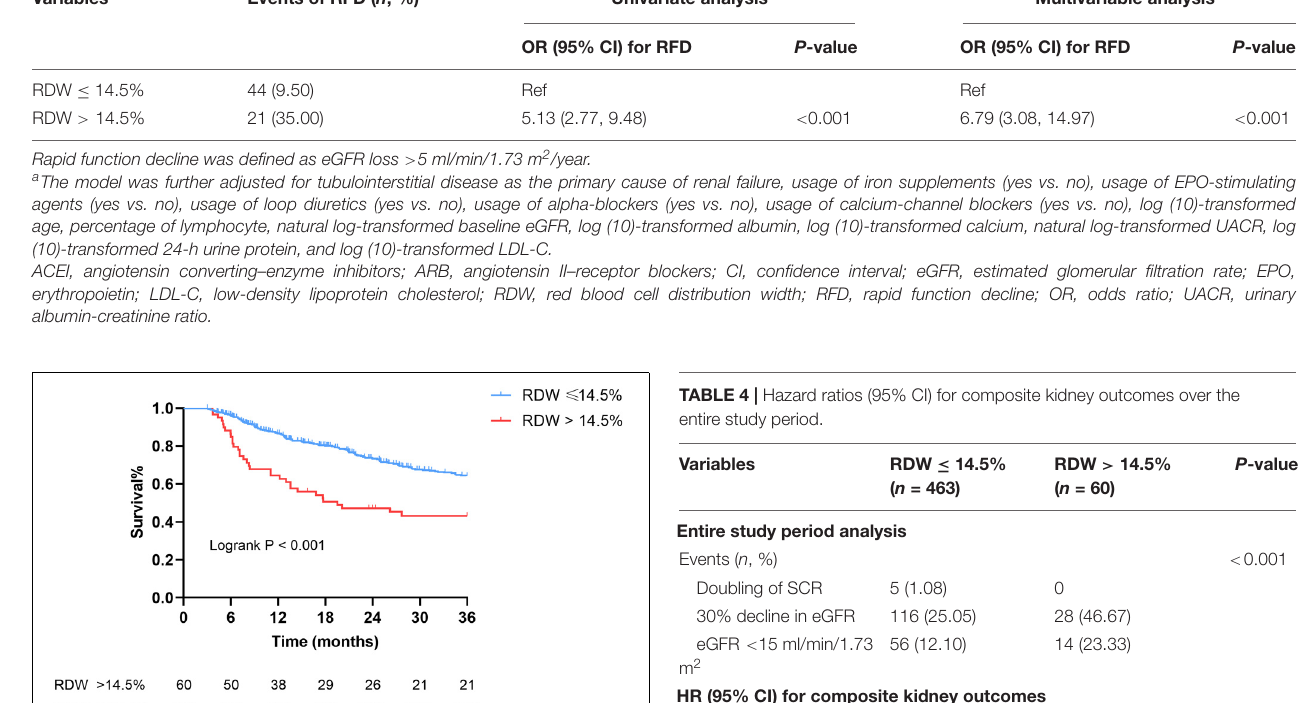
TABLE 3 | Univariate and multivariable adjusted odds ratios for rapid eGFR decline. Variables Events of RFD ( n , %) Univariate analysis Multivariable analysis a